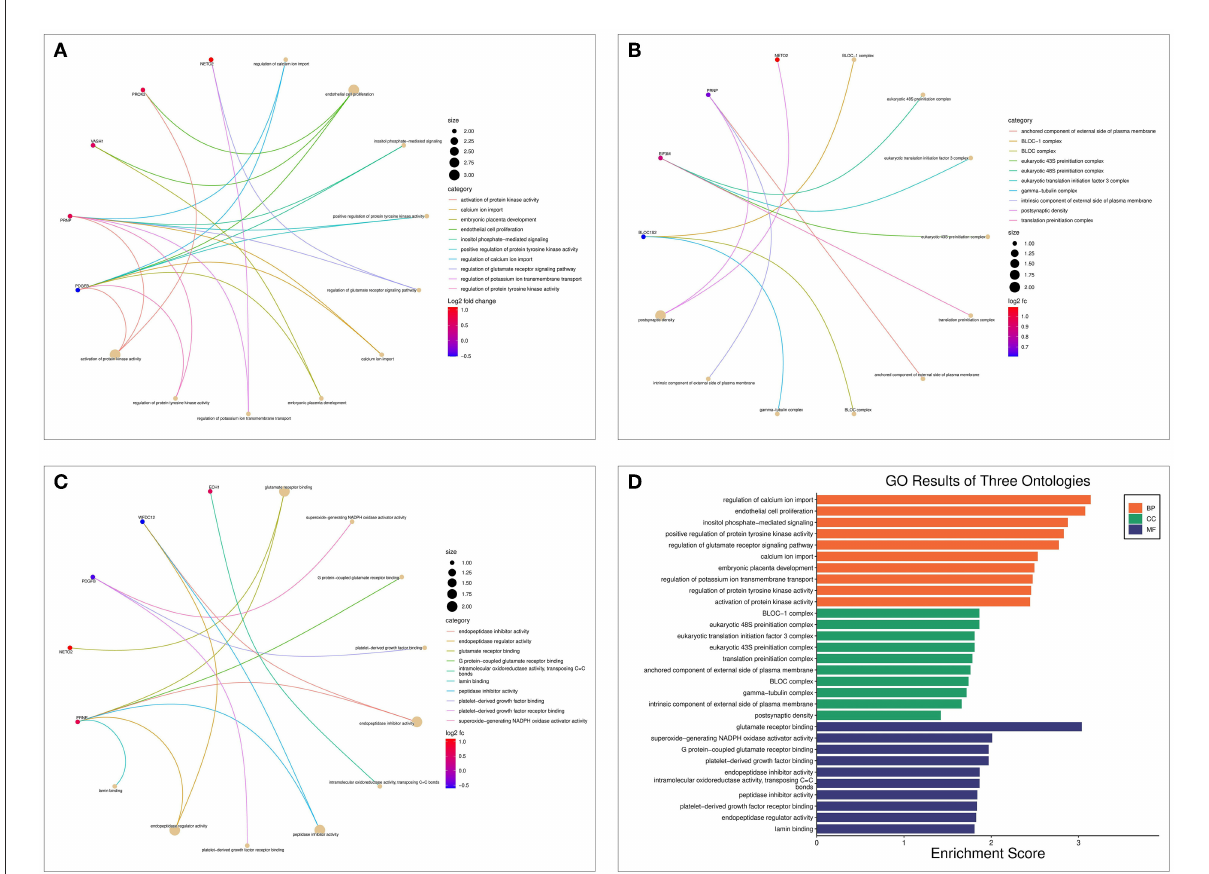
FIGURE4 Results of the GO enrichment analysis for AD-OP-related DEGs. (A) Chord diagram of biological processes functional analysis; (B) chord diagram of cell component functional analysis; (C) chord diagram of molecular function functional analysis; (D) histogram of GO enrichment analysis.